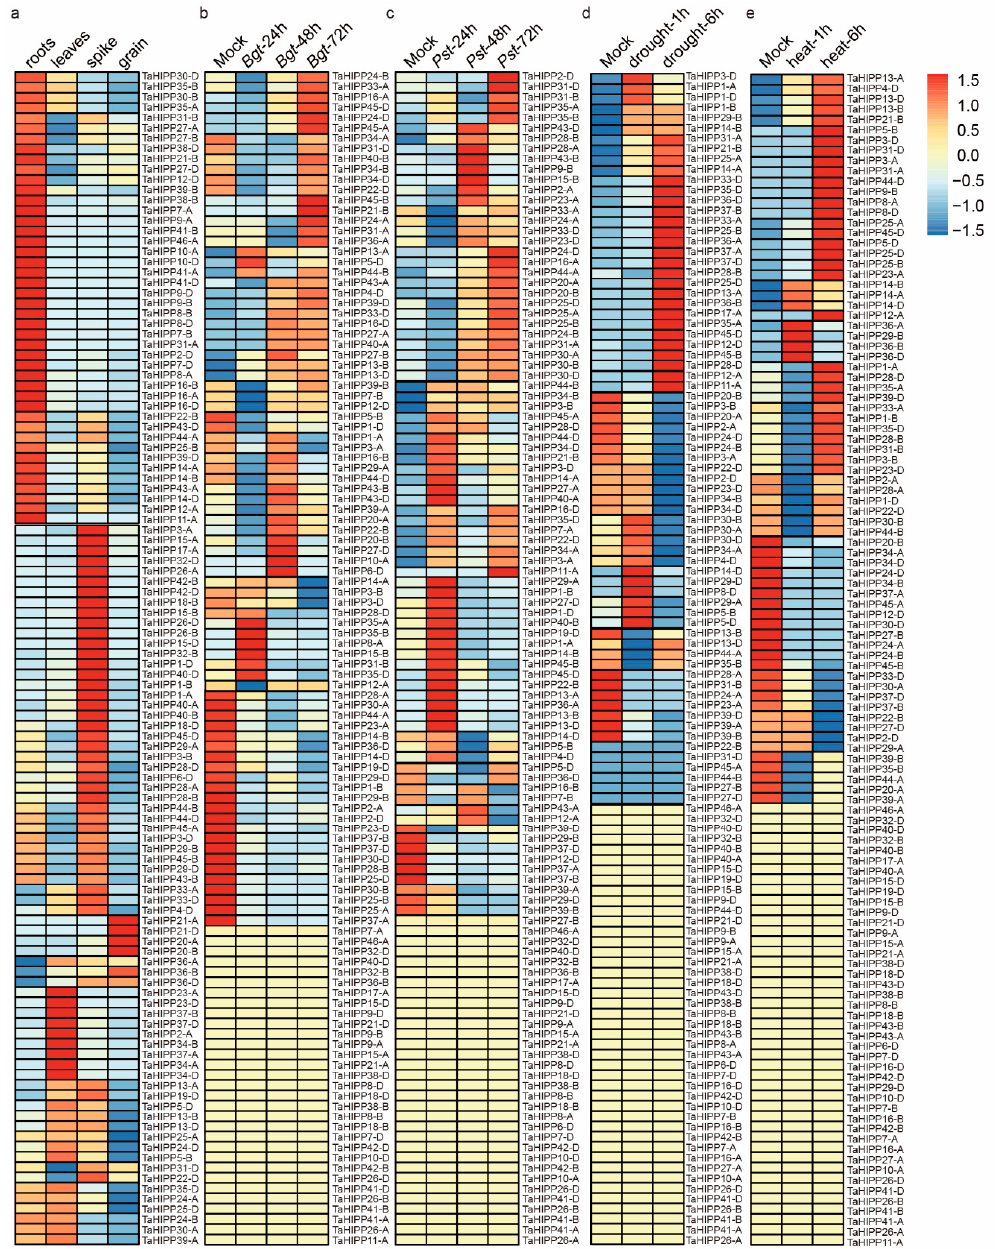
Figure 4. Heat map of the expression profiling of common wheat HIPPs in di ff erent tissues and under various stresses: the expression of HIPPs in di ff erent tissues ( a ), and their response to powdery mildew ( b ), yellow rust ( c ), drought ( d ), and heat treatment ( e ). The expression signal of each gene was based on the Z-score-normalization value. Abbreviations: Bgt : powdery mildew; Pst : yellow